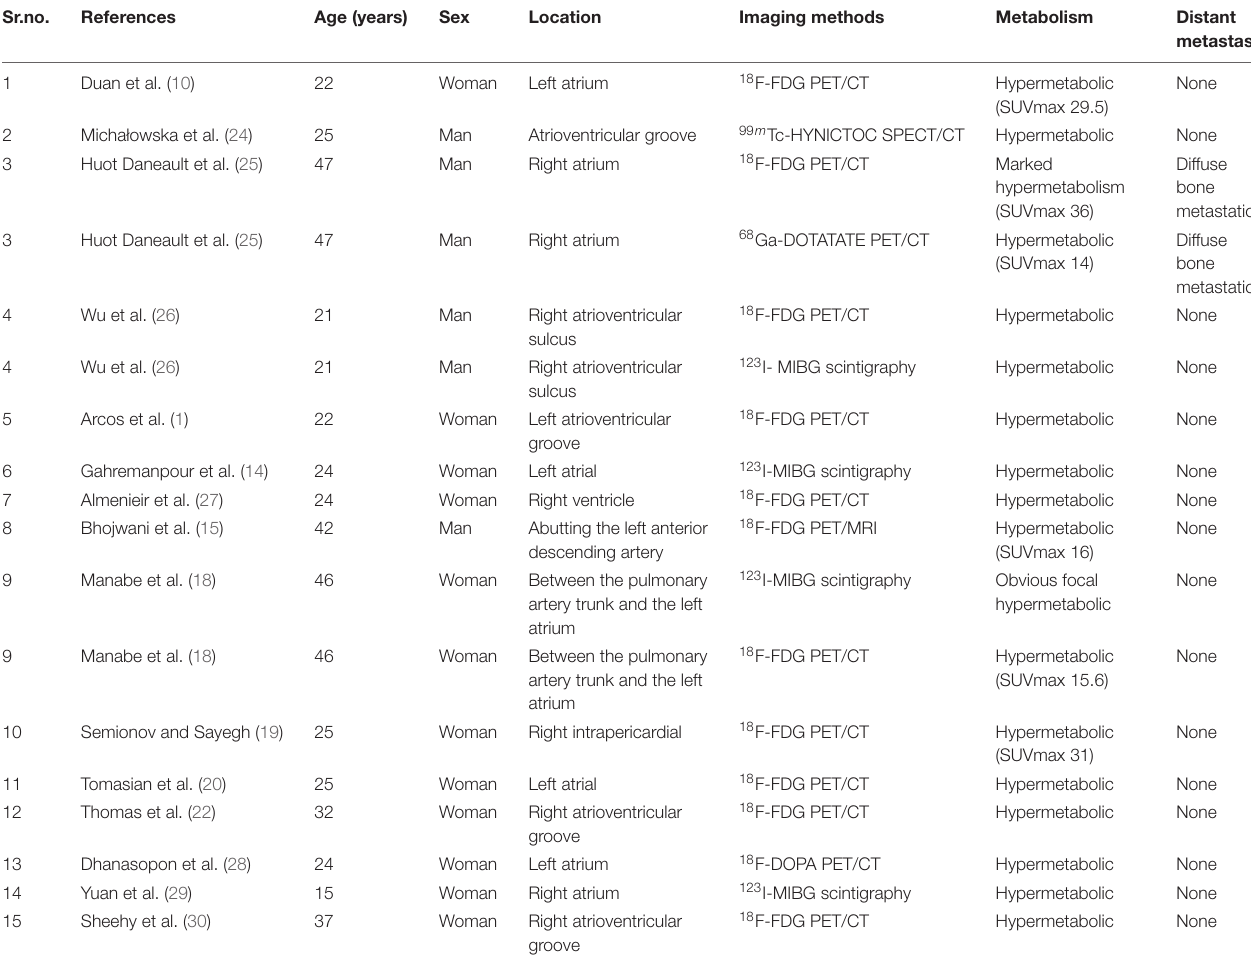
TABLE 3 | The single photon emission computed tomography (SPECT) and positron emission tomography (PET) findings of cardiac paraganglioma.